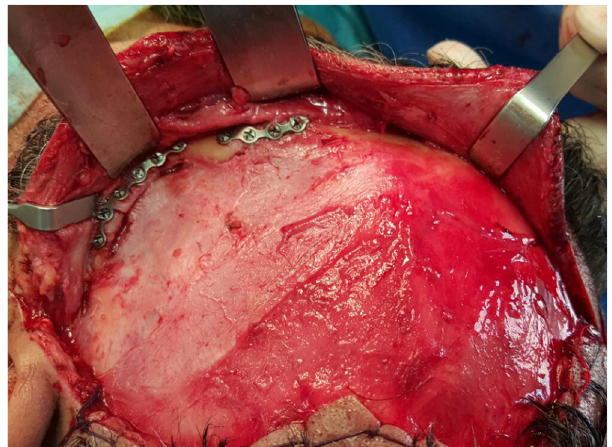
Fig. 2. Multifocal roof fracture, associated with a fracture of the zygomatic arch, treated by osteosynthesis via coronal access.